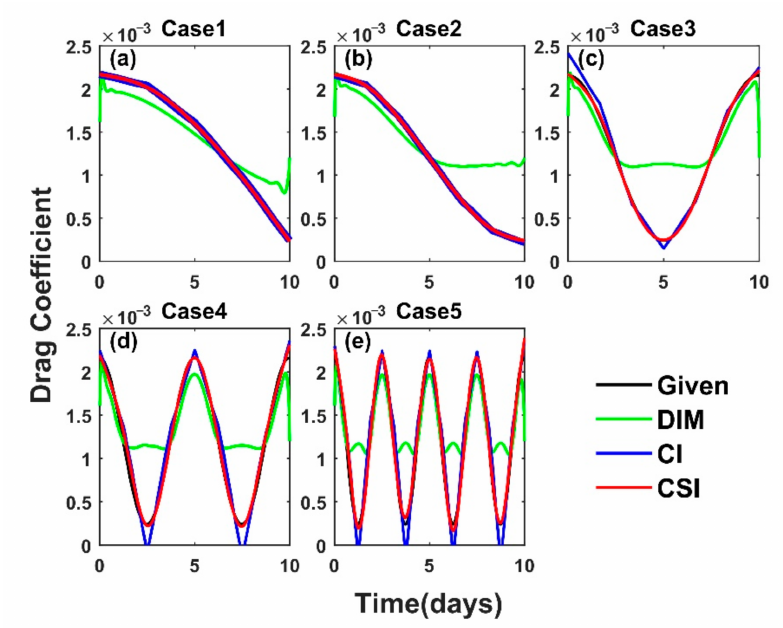
Figure 1. The prescribed distributions of WSDCs and inversion distributions of WSDCs obtained by the adjoint assimilation of different schemes. Panels ( a – e ) correspond to Cases 1–5,